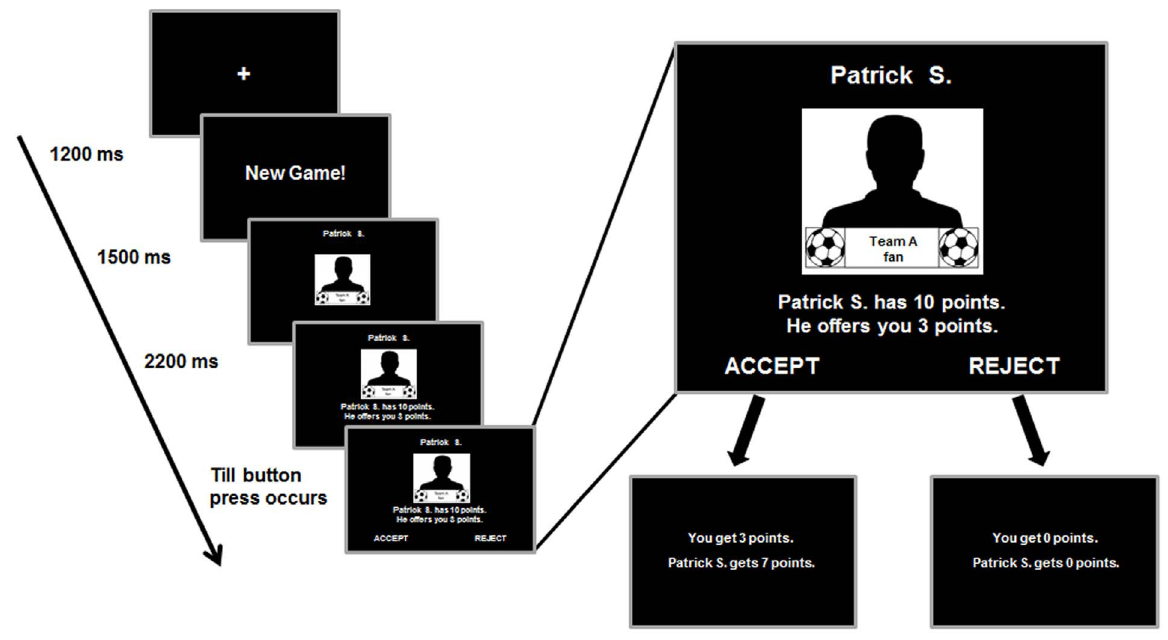
Figure 1. Example of an experimental trial in the computer-based Ultimatum Game (UG). Male soccer fans played the UG as responders and could either accept or reject the offer made by an anonymous proposer. They faced four different types of anonymous proposers: (1.) fans of the respondent‘s favorite soccer team ( ingroup ), (2.) fans of a soccer team rated as neutral ( neutral outgroup ), (3.) fans of an unknown cricket team ( unknown outgroup ), (4.) fans of the soccer team most hated by the respondent ( antagonist outgroup ). Offers made by these agents were either fair (i.e., offering 4 or 5 points out of ten) or unfair (i.e., offering 1, 2 or 3 points out of ten). The UG was played in two consecutive contexts: (1.) without a competition between groups ( neutral context ), and (2.) with an instructed group competition ( competitive context